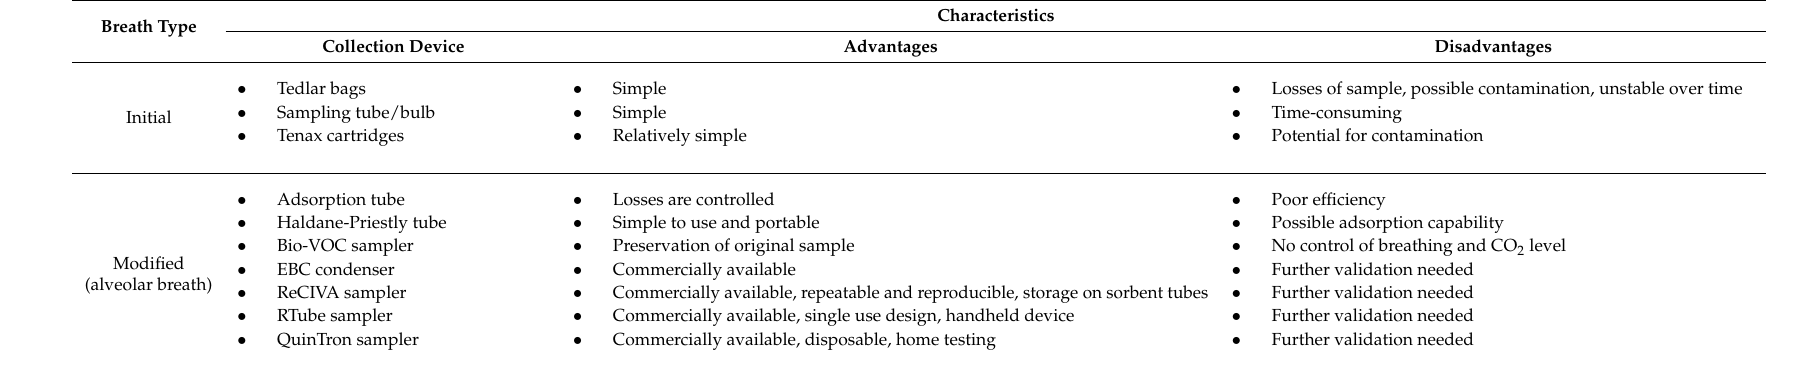
Table 1. Breath sample collection devices and their